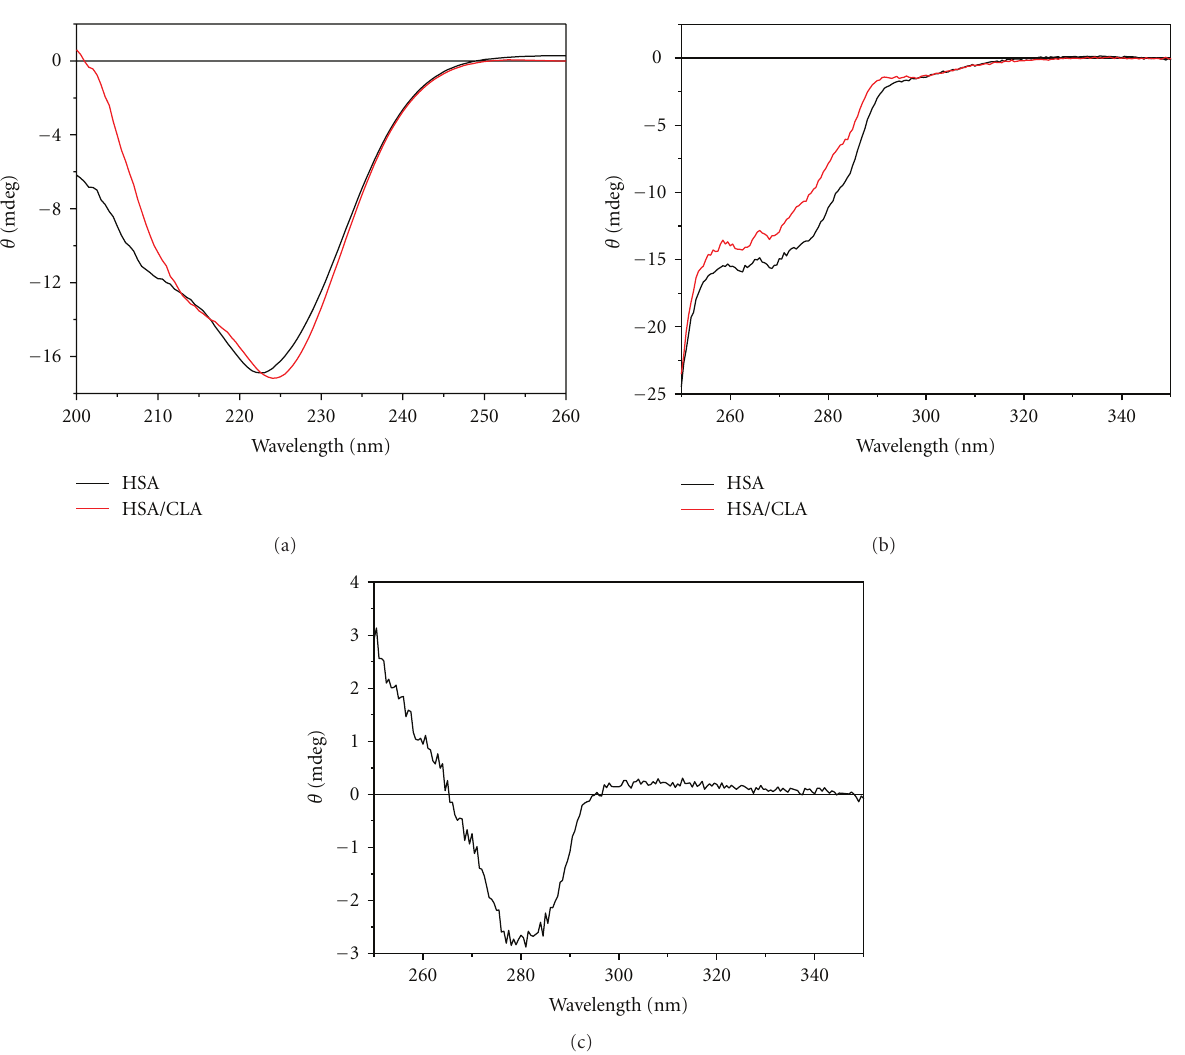
Figure 5: Circular dichroism spectra of HSA (18 μ M), and HSA/CLA (18 μ M, 50 μ M) in 10 mM PBS, 5% DMSO, pH = 7.4 bu ff er taken in the (a) far-UV and (b) near-UV spectral region. Spectra were an average of 4 spectra, and respective background spectra were subtracted accordingly. (c) Di ff erence CD spectrum of HSA (18 μ M), and HSA/CLA (18 μ M, 50 μ M) solutions for the near-UV region indicates some conformational changes after